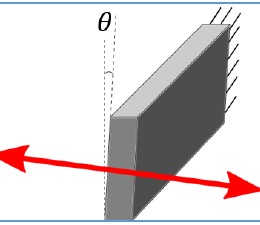
Figure 1. Non vertical extrusion exploited in the FEM model to represent sidewall angle of a real MEMS structure which is commonly recognized as the main common source of quadrature for out of plane (x- and y-axes).